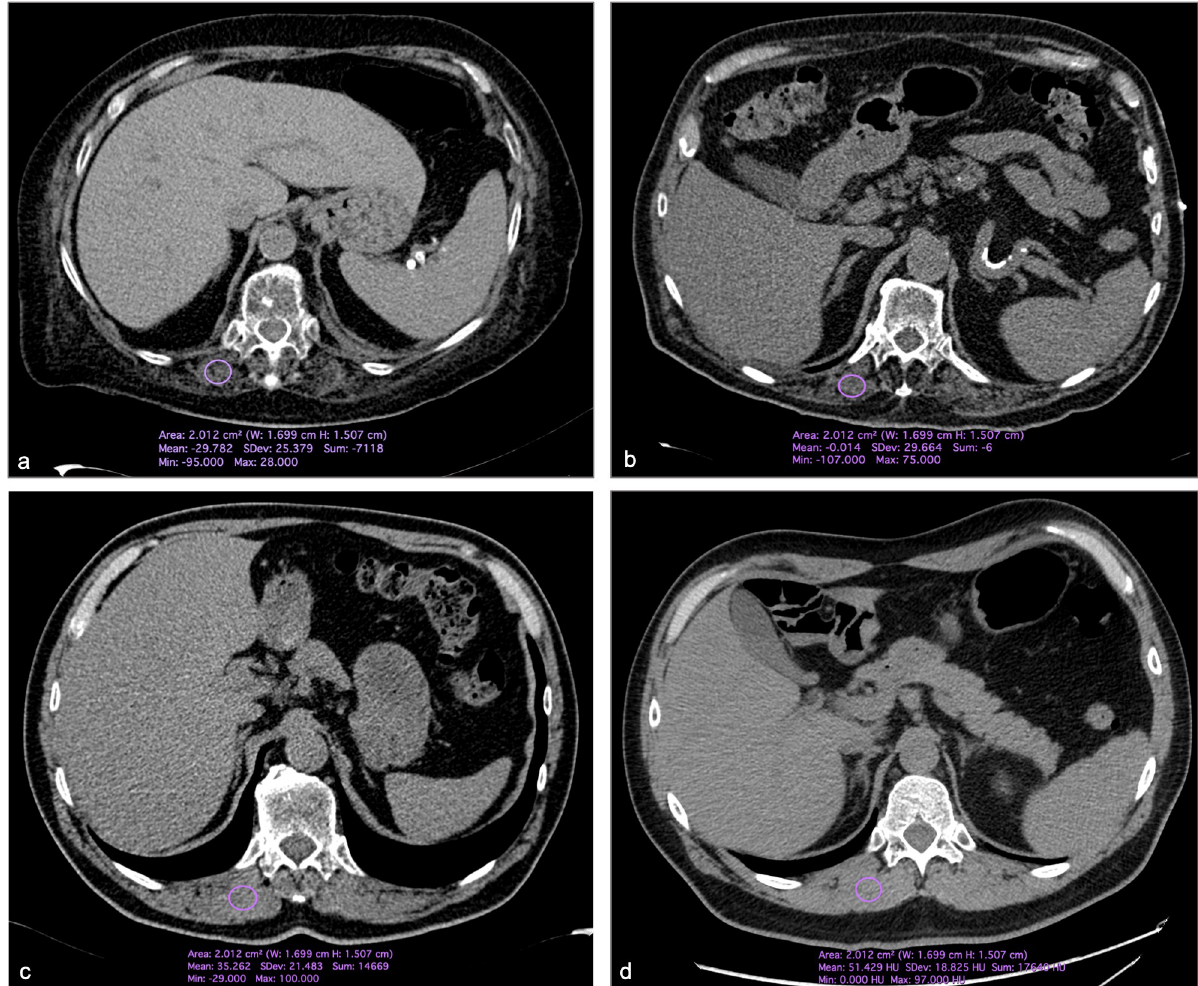
Fig 2. Axial Computed Tomography images of four patients with COVID-19. In particular, in a and b, one 74 years-old female and one 82 years- old male with reduced muscle mass (i.e., < 30 Hounsfield unit) hospitalized in intensive care unit. In c and d, two male patients (54 years old in a and 65 years old in b) hospitalized in COVID-19 wards demonstrating muscle values above the threshold for muscle